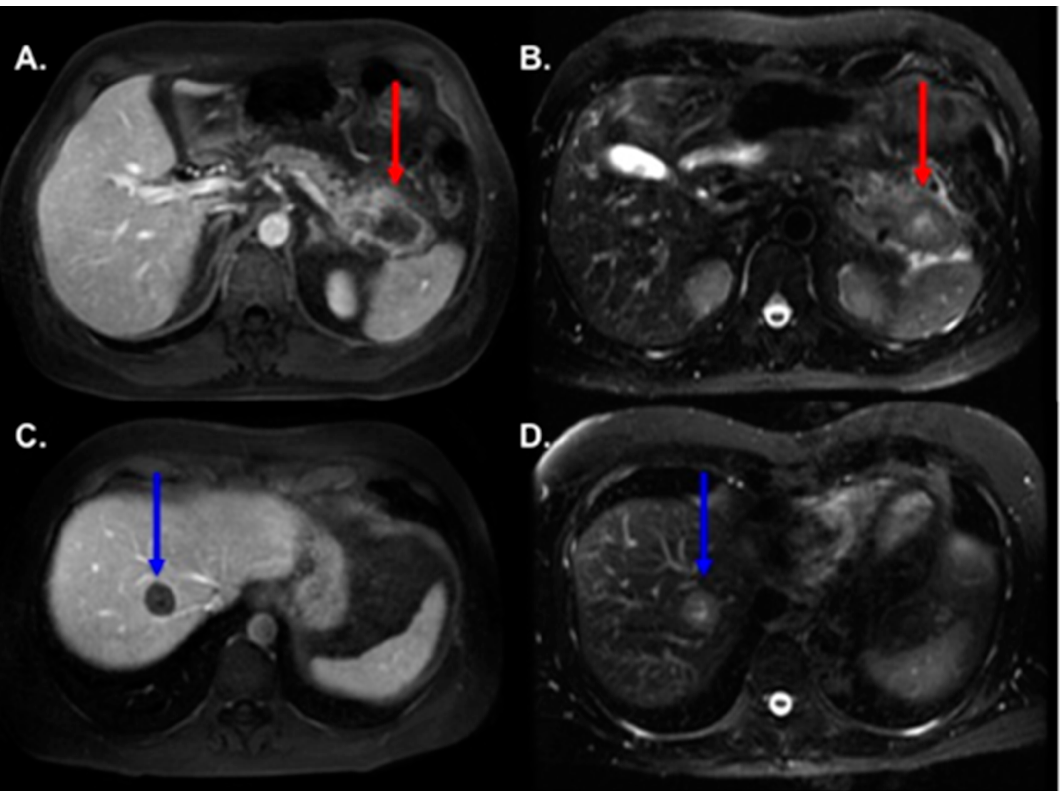
Figure 2. A 51-year-old male with a necrotic mass in the tail of the pancreas. ( A ) Axial T1 fat-suppressed portal venous phase image demonstrates central hypo-enhancement (red arrow). ( B ) Axial T2 fat-suppressed image shows associated hyperintensity (red arrow). ( C , D ) A hypo-enhancing, T2 hyperintense lesion is seen within the liver (blue arrows). Endoscopic ultrasound biopsy revealed primary PDAC with necrosis.